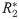
Axial RESUME maps of the brain.Slices at the level of midbrain (a), basal ganglia (b) and centra semiovalia (c) of: 1) R2* map ([0 ∼ 50] s−1); 2) R1 map ([0 ∼ 2] s−1); 3) PD map ([0 ∼ 1] arbitrary units); 4) QSM ([−300 ∼ 300] ⋅ 10−9).